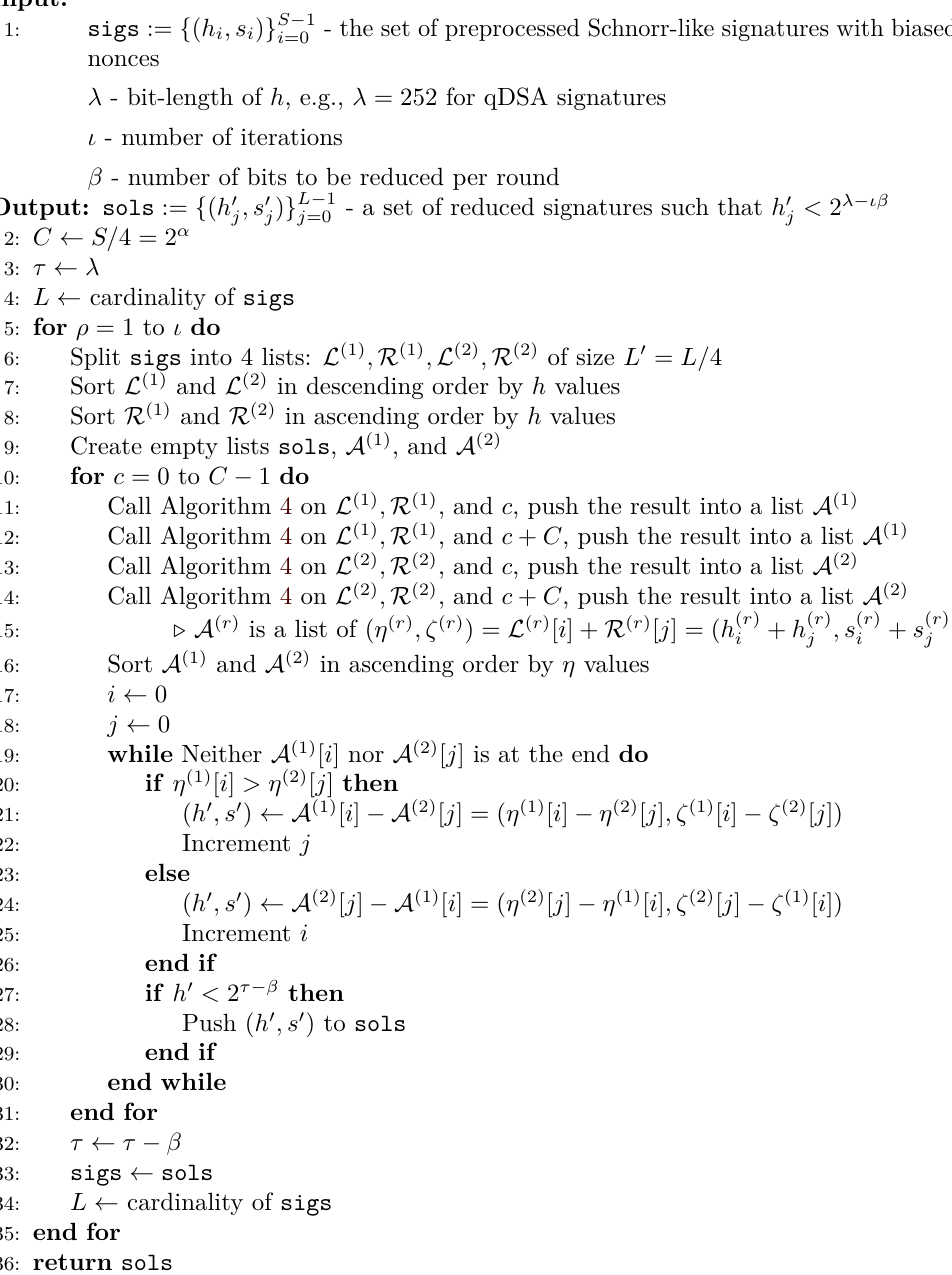
Algorithm 3 Parallelizable Schroeppel–Shamir-based range